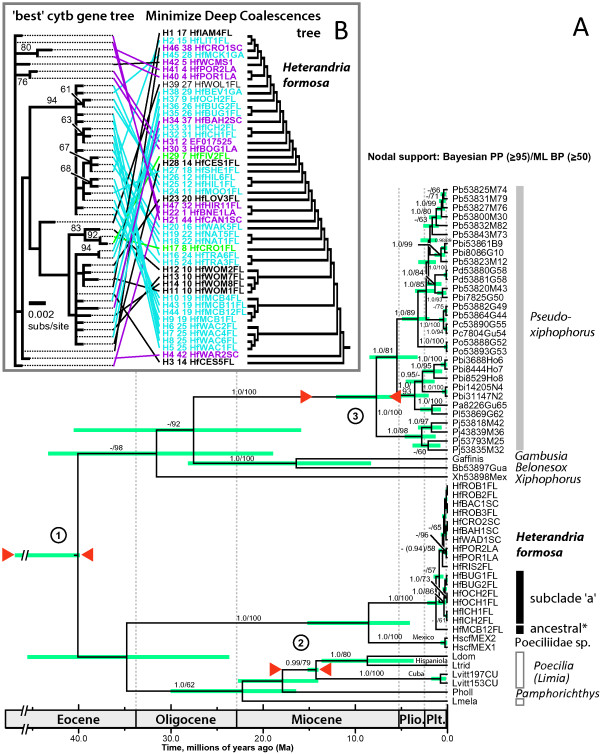
Chronogram of Heterandria formosa and related poeciliid species diversification, and gene tree results. A) Chronogram resulting from Bayesian relaxed-clock coalescent-dating analysis in BEAST based on mitochondrial cytb and RPS7 variation. Tip labels are sequence codes including population, site number, and specimen code for each individual sequenced (details in Figure 1 and Table 1). Node bars (dark blue) are 95% highest posterior densities for node ages. The analysis included three lognormally modeled fossil/biogeographic calibration points (red triangles enclose bounds of constraints). Mean node ages of interest are discussed in detail in the text. Nodal support values are of the form: Bayesian posterior probabilities (PP; ≥95)/maximum-likelihood bootstrap proportions (BP; ≥50). B) Comparison between the 'best’ gene tree of H. formosa cytb haplotypes and the 'Minimize Deep Coalescences’ species tree (at right) inferred from the haplotype tree using Maddison and Knowles’ [76] method, with BP ≥ 50 by each node.